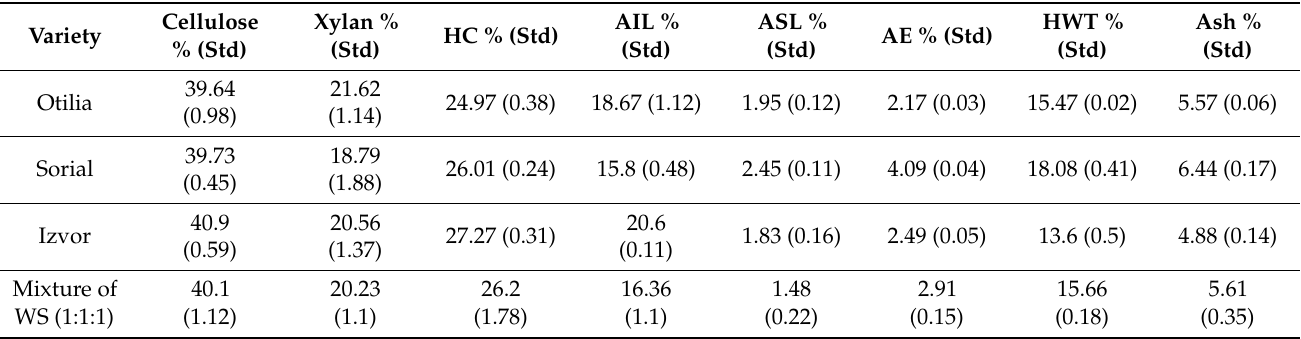
Table 2. Chemical composition of wheat straw varieties as raw materials in the